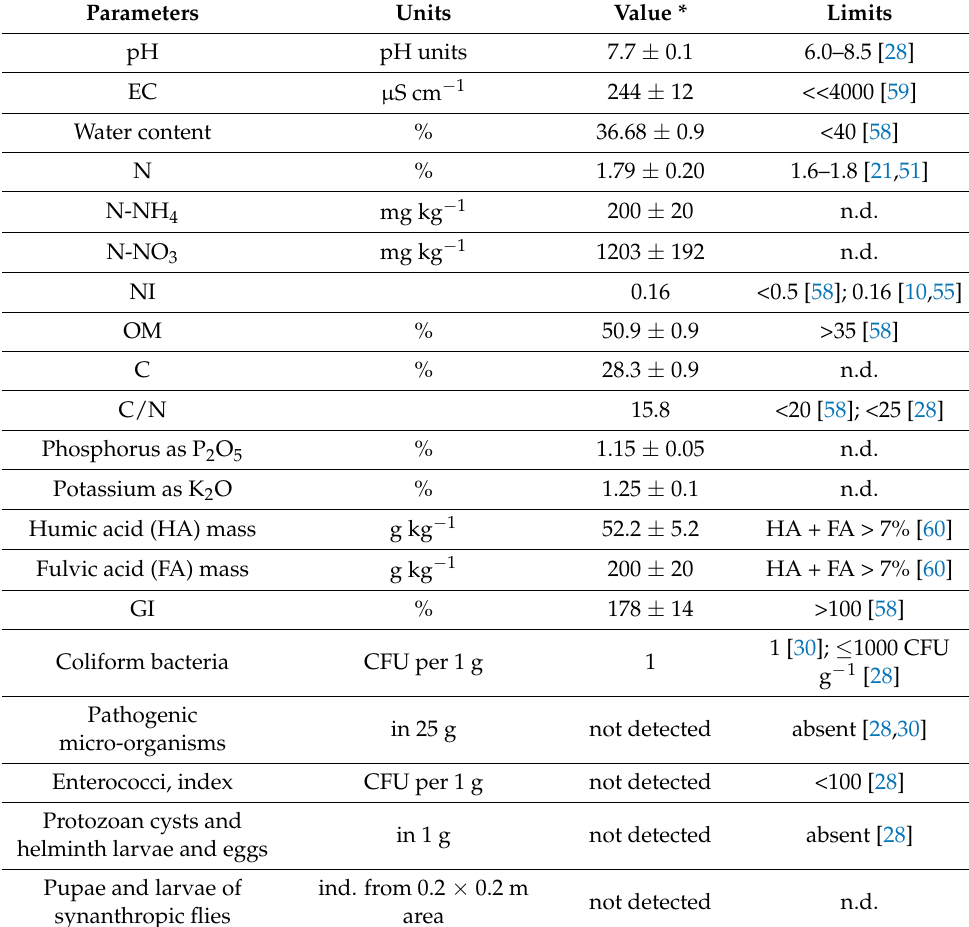
Table 3. Agrochemical and sanitary microbiological parameters of mature